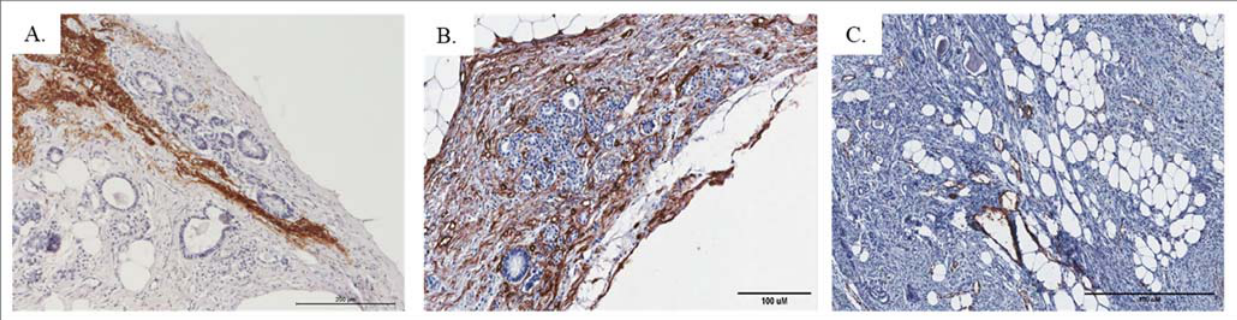
Figure 5. Area of carcinoid with GFAP (( A ). objective magn. ×20), CD 34 (( B ). objective magn. ×10) and CD31 (( C ). objective magn. ×10).